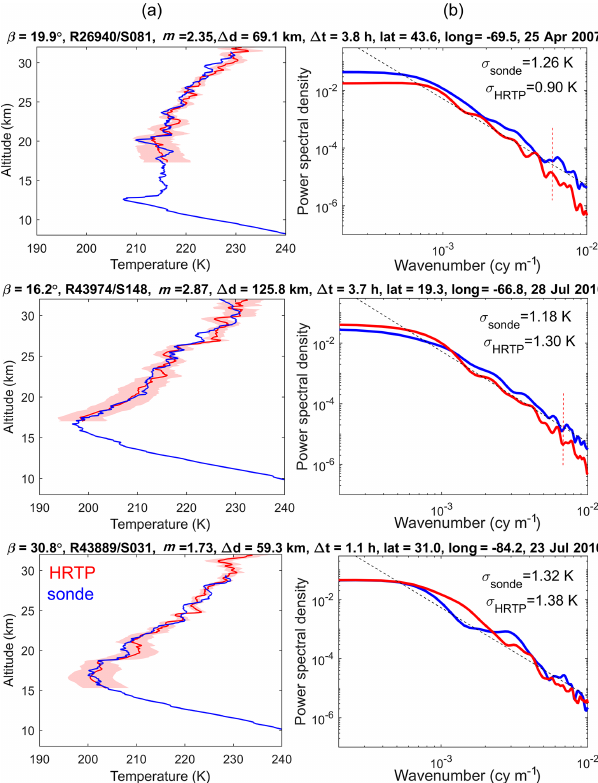
Figure 8. As Fig. 7, but for oblique occultations and/or dim